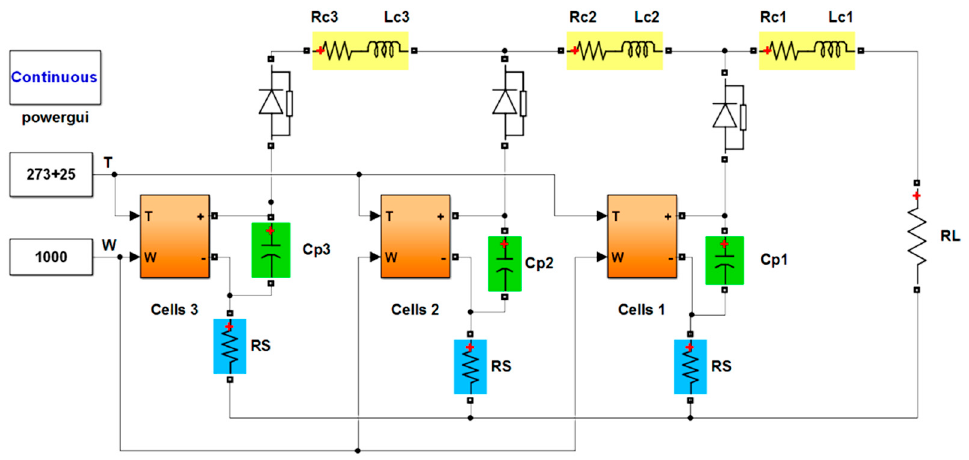
Figure 3. Solar panel simulation model in MatLab package.